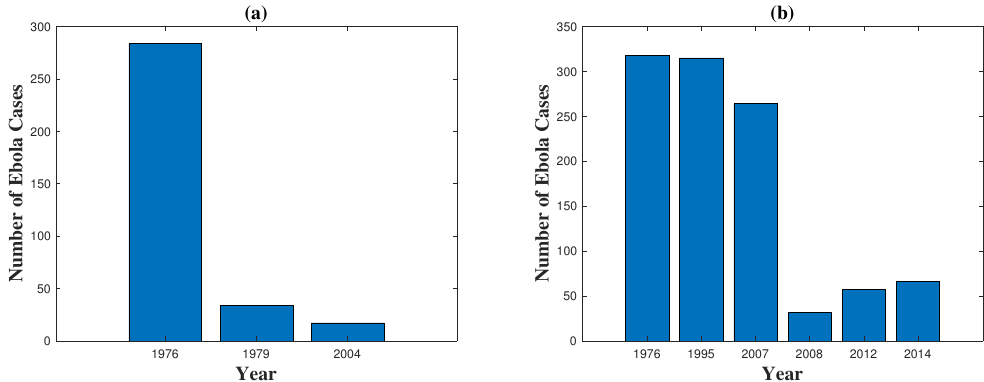
Fig. 1: Ebola outbreaks plots for (a) Sudan and (b) the Democratic Republic of Congo.